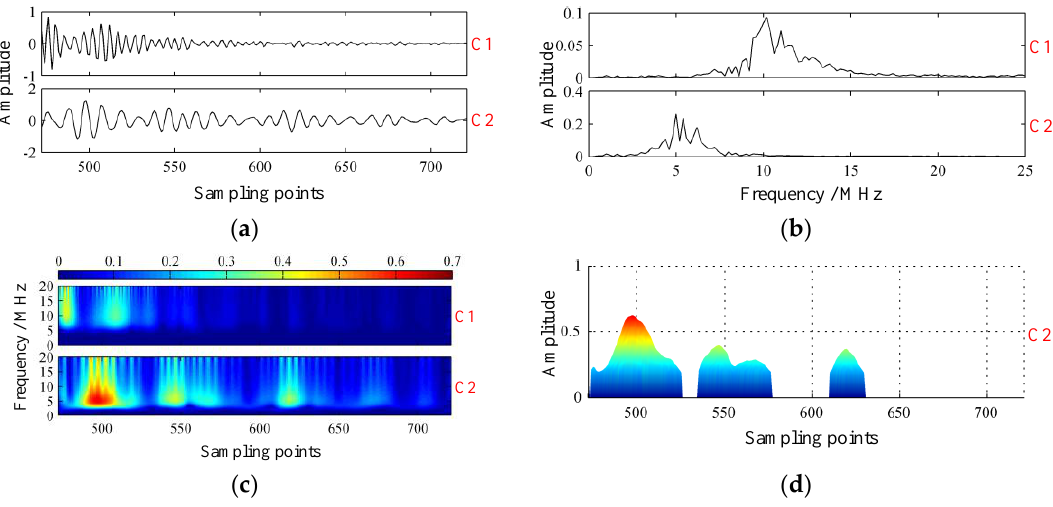
Figure 12. Modes extracted by VMD with parameters K = 2 and α = 4. ( a ) Intrinsic mode functions; ( b ) spectrums of intrinsic mode functions; ( c ) GST spectrums of intrinsic mode functions; and ( d ) projection of GST spectrum of C2.